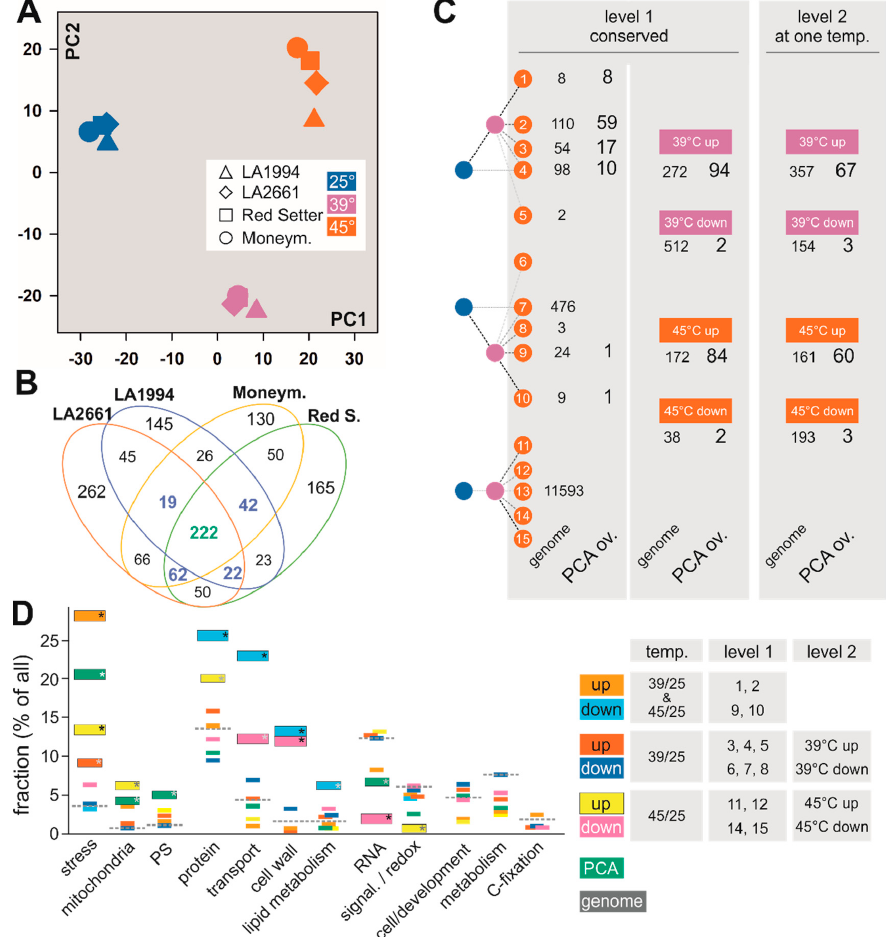
Figure 3. Common responses to different temperatures in the different genotypes. ( A ) Principle Component Analysis (PCA) for the transcript levels in the individual genotypes at different temperatures was performed using the average values of the two experiments. The distribution of PC1 and PC2 is shown. The symbol and color legend is indicated. ( B ) The genes contributing most to the PC1 and PC2 have been selected and the overlap between different genotypes is shown. ( C ) The expression profile of all genes (genome, small letters and numbers), and of the 222 genes found to define PC1 and PC2 in all genotypes (PCA ov., large letters and numbers) was classified as described in section 2.6. Level 1 shows the genes with identical profile in all genotypes. For an overview, the number of genes up or downregulated at 39 °C or 49 °C in comparison to control is shown as well. Level 2 indicates genes with identical profile with respect to 39 °C/25 °C or 45 °C/25 °C, but not with respect to other comparisons. Note: (i) a gene in level 1 is not counted in level 2; (ii) for the accumulated information in level 1 and level 2, a gene can be counted twice. ( D ) All genes of the classes indicated on the right, selected by their contribution to PC1 and PC2 in all four genotypes (PCA overlap, green), or all genes in the genome (grey dashed line), were sorted into MapMan categories (Table S4). The percentage of genes in a given category was calculated in relation to the number of selected genes in a given class. The significance was determined by Fisher’s exact test (black/white asterisk: p < 0.01; grey asterisk: p < 0.05). C-fixation unifies categories 2–8, 25; cell and development: 31, 33, metabolism: 12–19, 22–24; signaling and redox: 20, 30 (Table S4). Miscellaneous/unknown, and DNA categories are not shown.